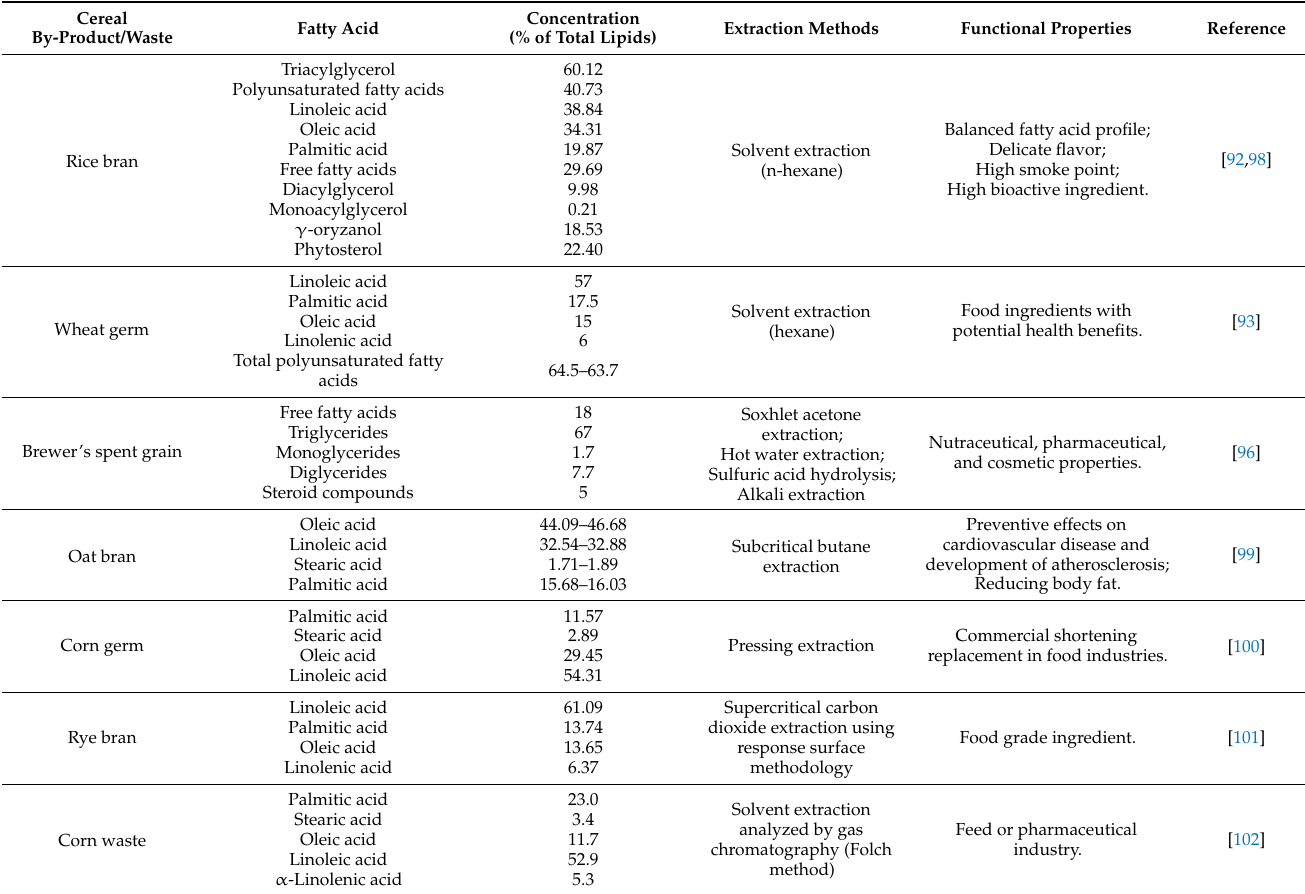
Table 3. Fatty acid composition of cereal by-products and